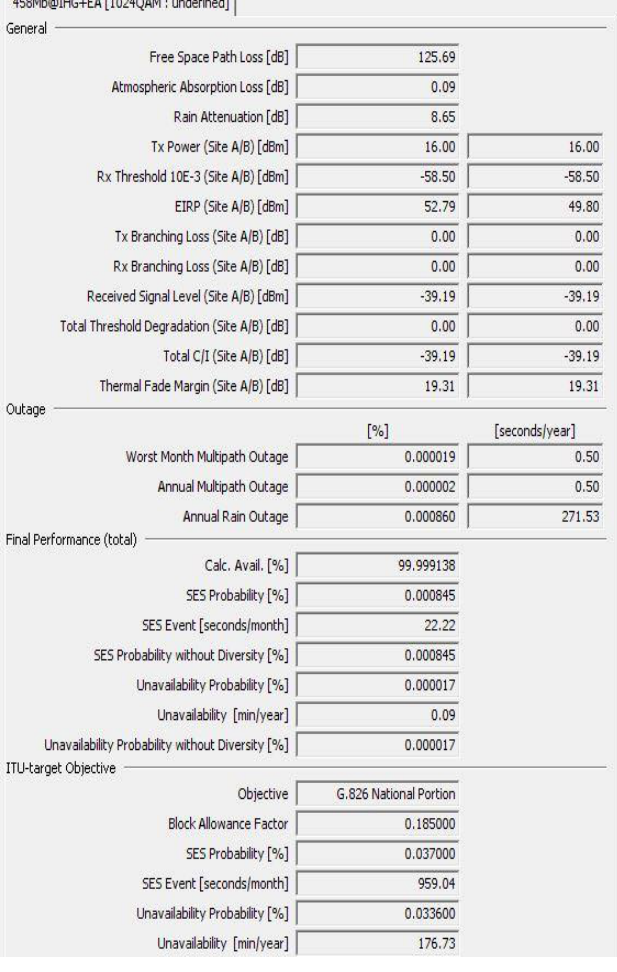
Figure 3 . The report generated by Netcop at the design of link E-Z with with one 0.3 m diameters antenna and one 0.6 m diameters